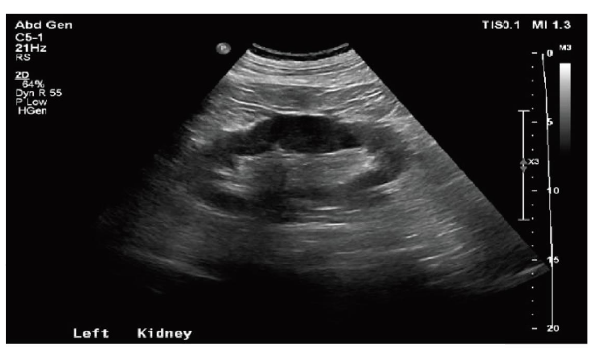
Figure 6: Renal US left